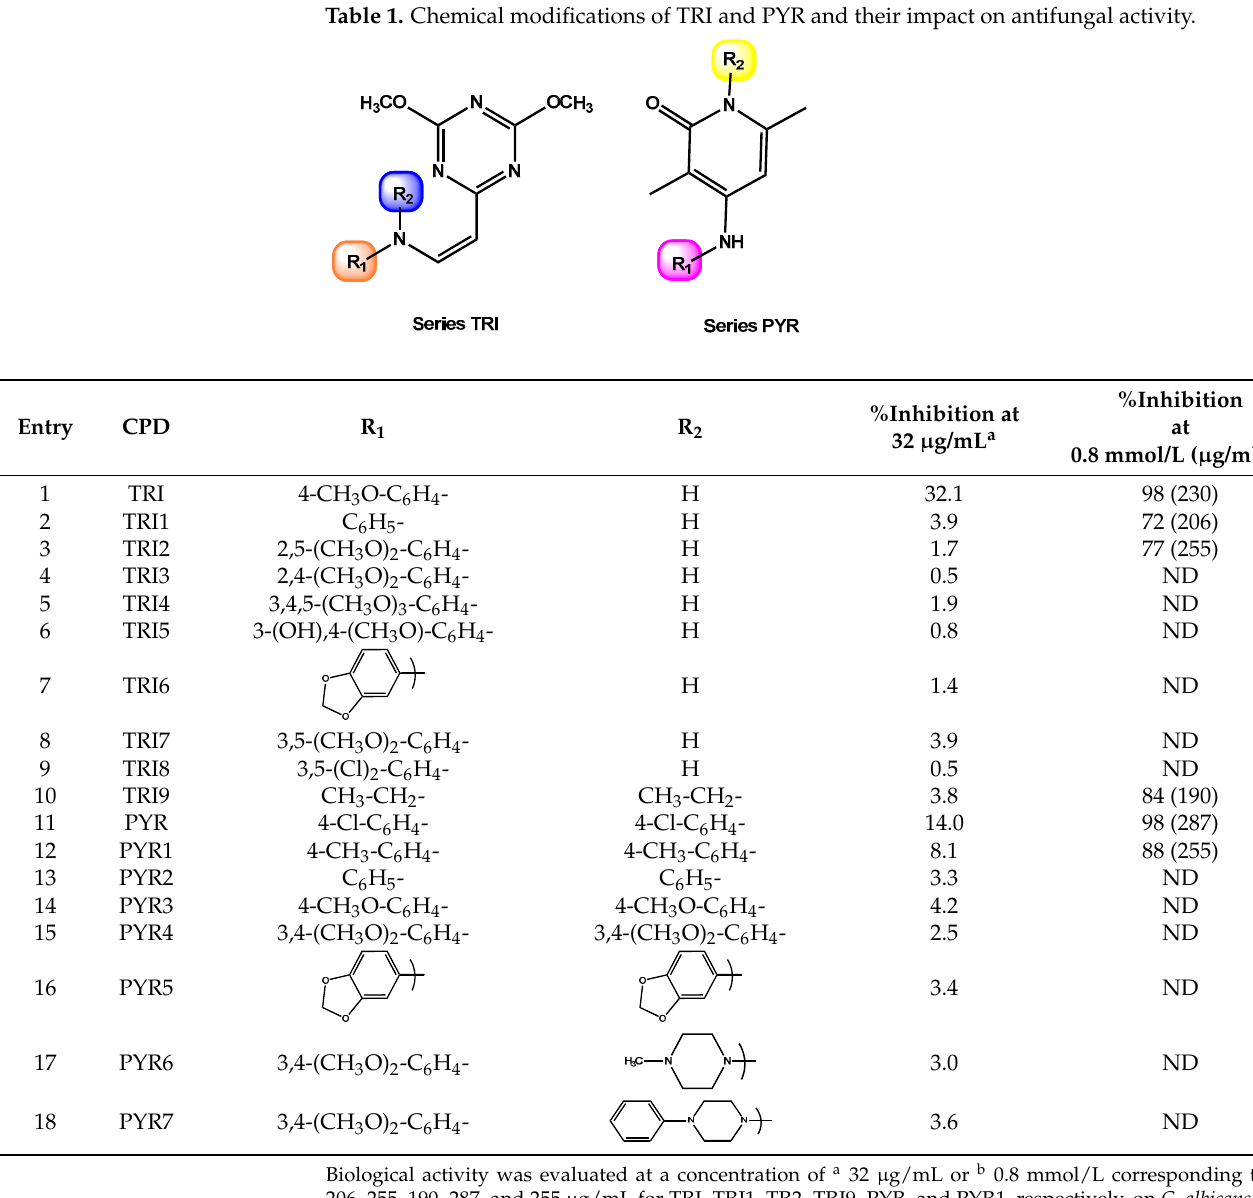
Table 1. Chemical modifications of TRI and PYR and their impact on antifungal activity.